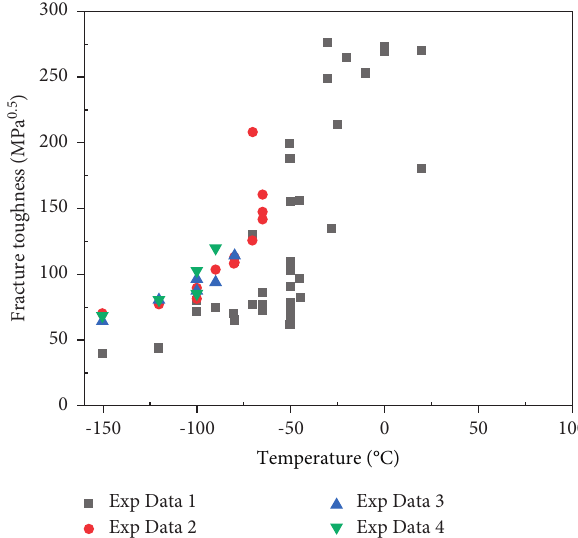
Figure 14: Temperature-dependent fracture toughness test data of the referenced RPV steel.